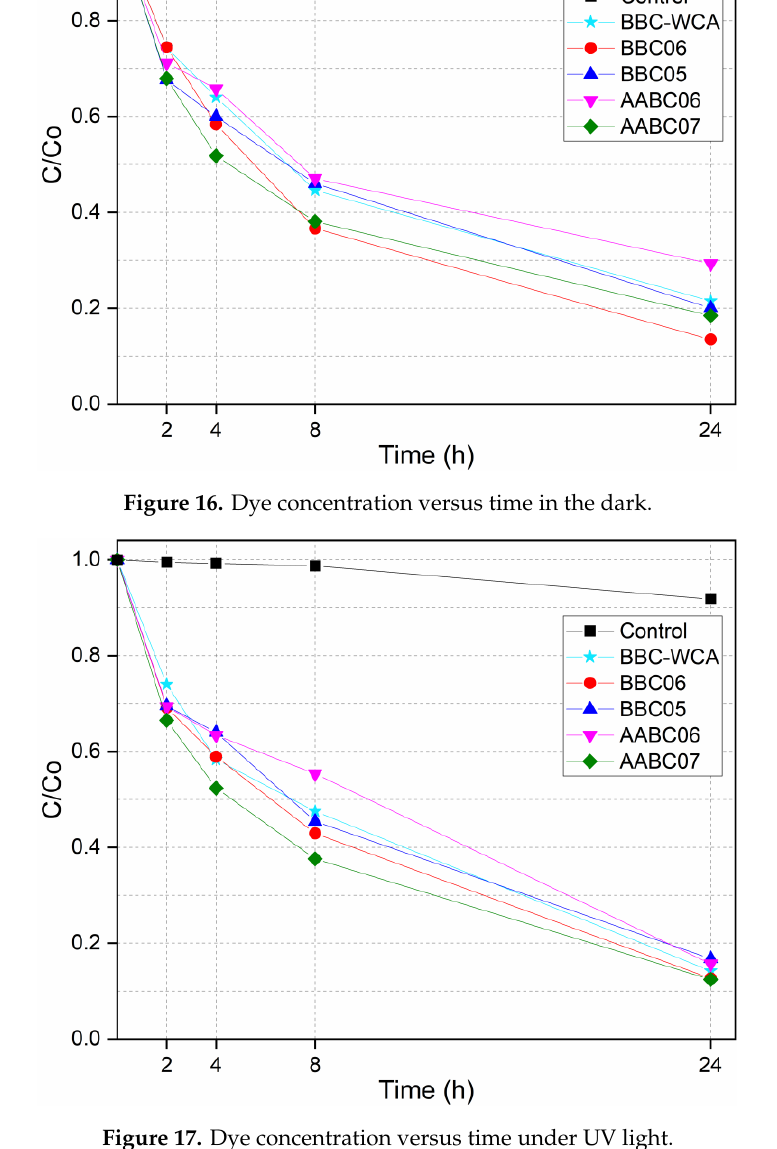
Figure 17. Dye concentration versus time under UV light.